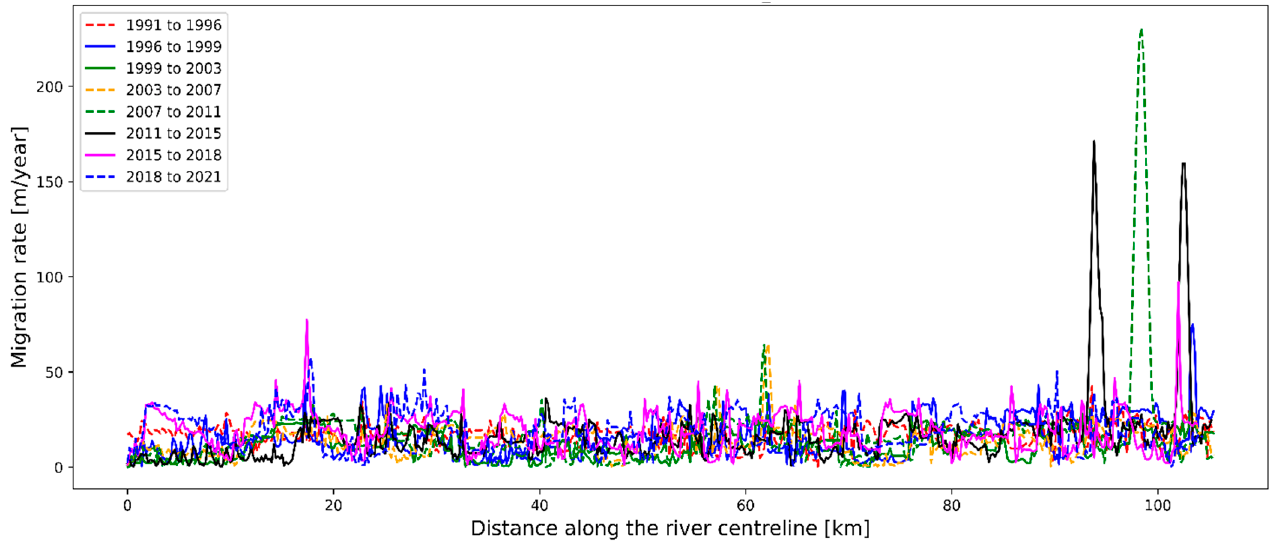
Figure 9 . Spatial and temporal variation of river centerline migration rates . Figure 9. Spatial and temporal variation of river centerline migration rates. When compared with the river migration rates of Deduru Oya, the Lower Mahaweli River exhibits minor values except for the three bends described above. The average centerline migration rates are within the limit 20–40